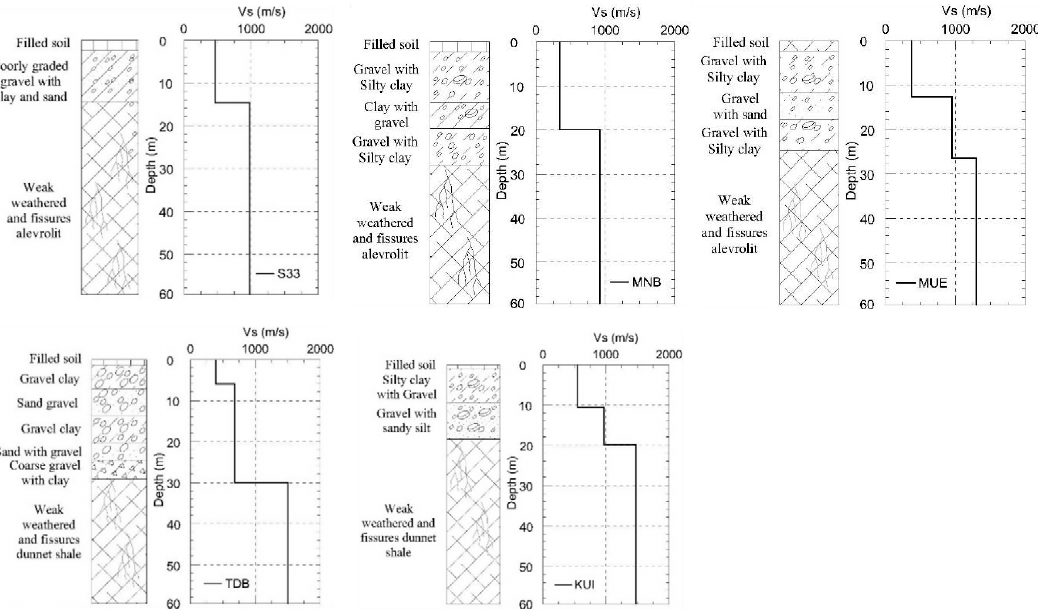
Figure 7. Variations of theoretical site amplification analysis.